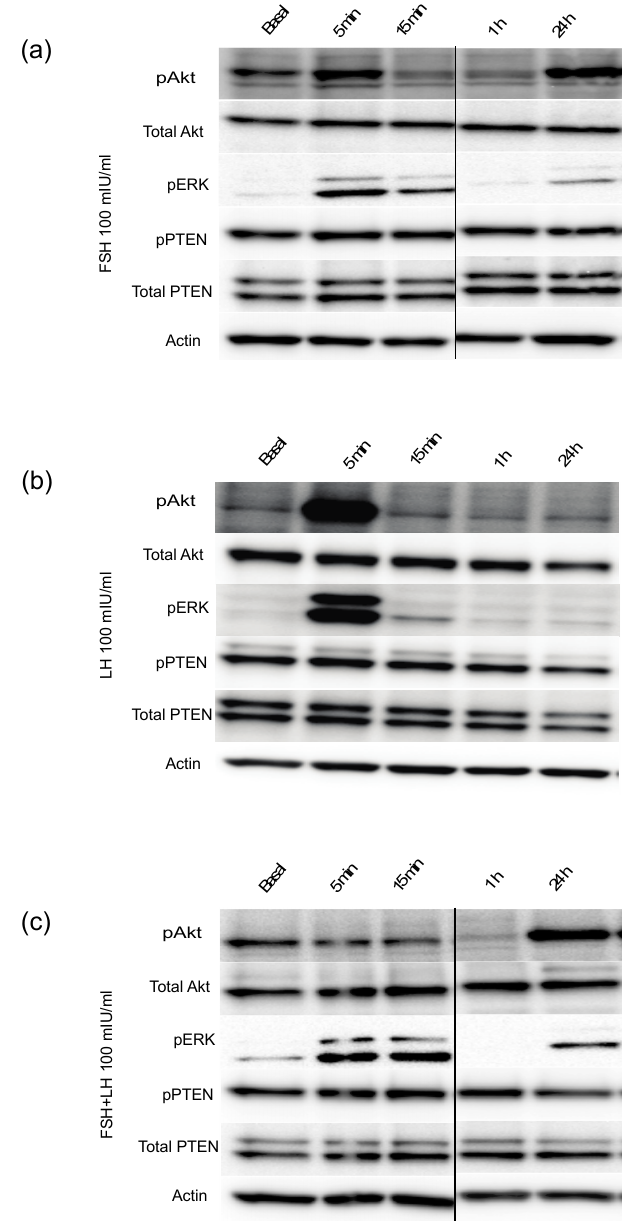
Figure 2. Gonadotropins upregulate pAkt and pERK expression in MOSE cells. Activated pAkt and pERK expression was observed in MOSE after treatment with 100 mIU/mL of ( a ) FSH; ( b ) LH or ( c ) FSH+LH. Activated p-PTEN and total PTEN levels were similarly probed. Protein was normalized to actin. All gels were run in 3 independent experiments with a representative image